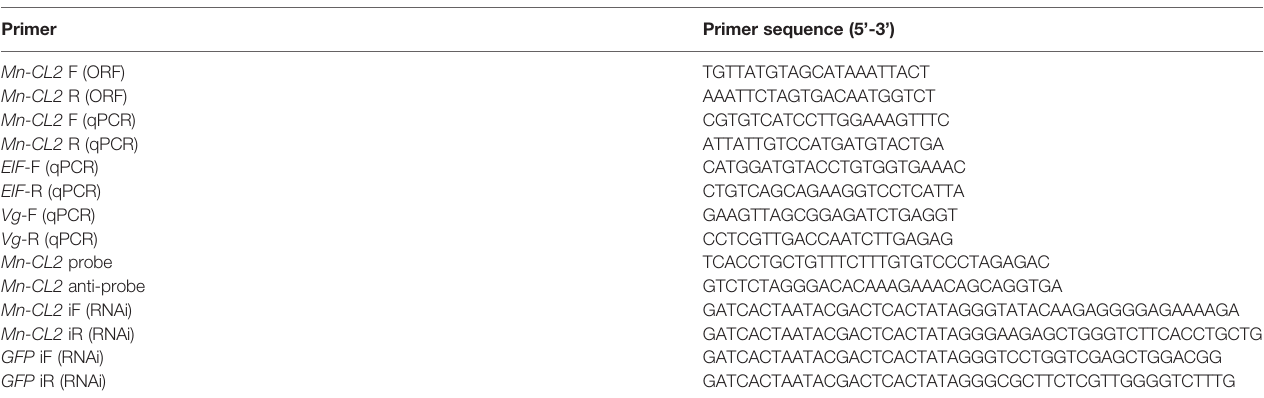
TABLE 1 | Primers used in this